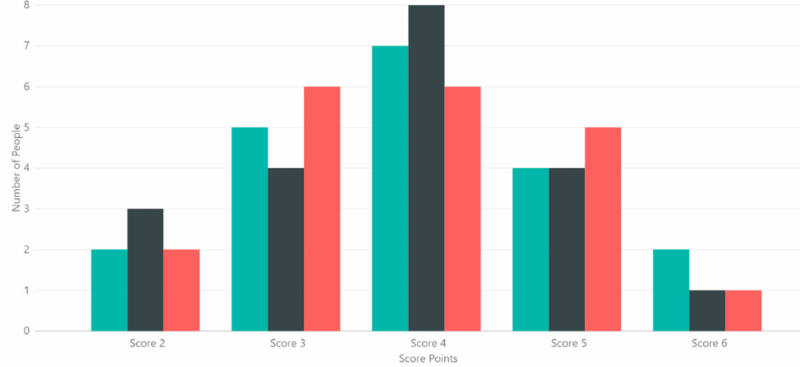
Figure 15. Individual score distribution in each group (pre-test).